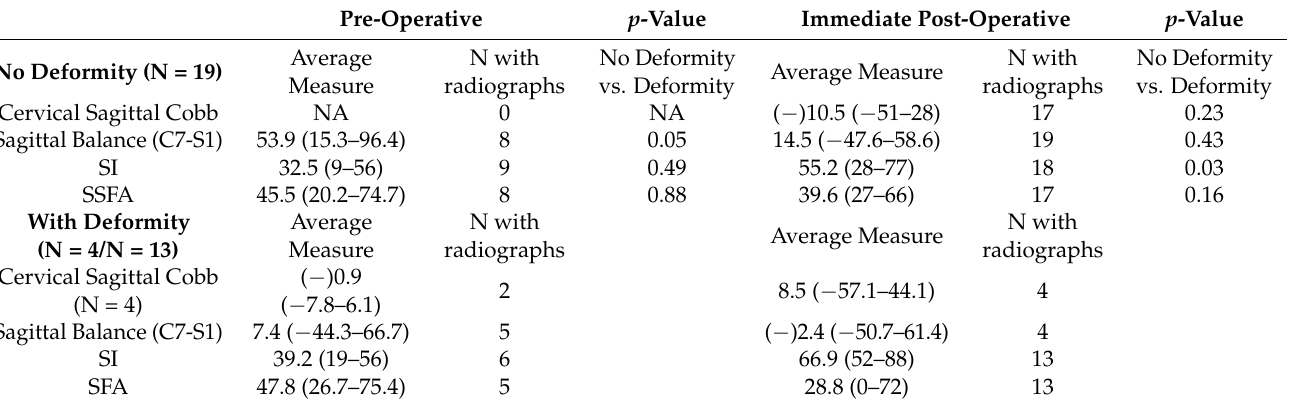
Table 5. Temporal analysis of sagittal parameters between those that ultimately developed a deformity or did not. Lack of adequate upright radiographs limits interpretation of the data, however, from the available data no significant differences were